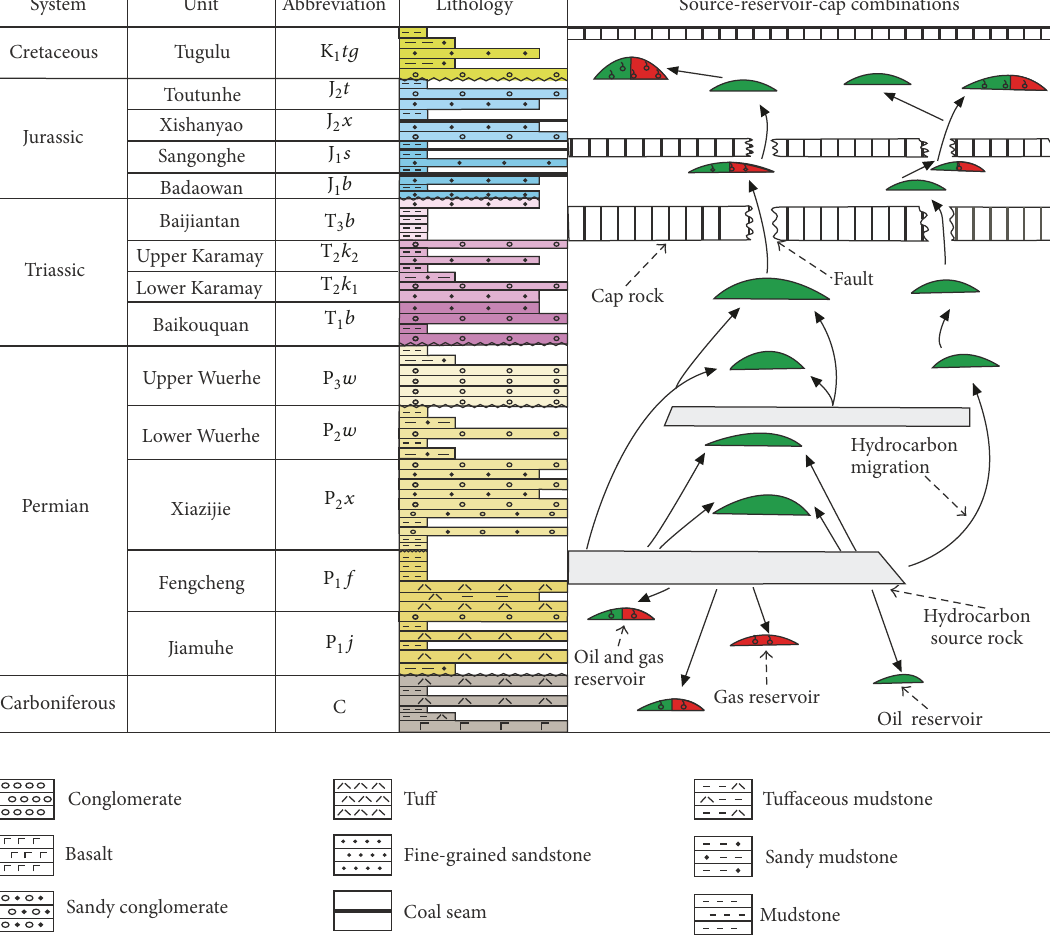
Figure 2: Generalized stratigraphy and source-reservoir-cap rock combinations in the central Junggar Basin.